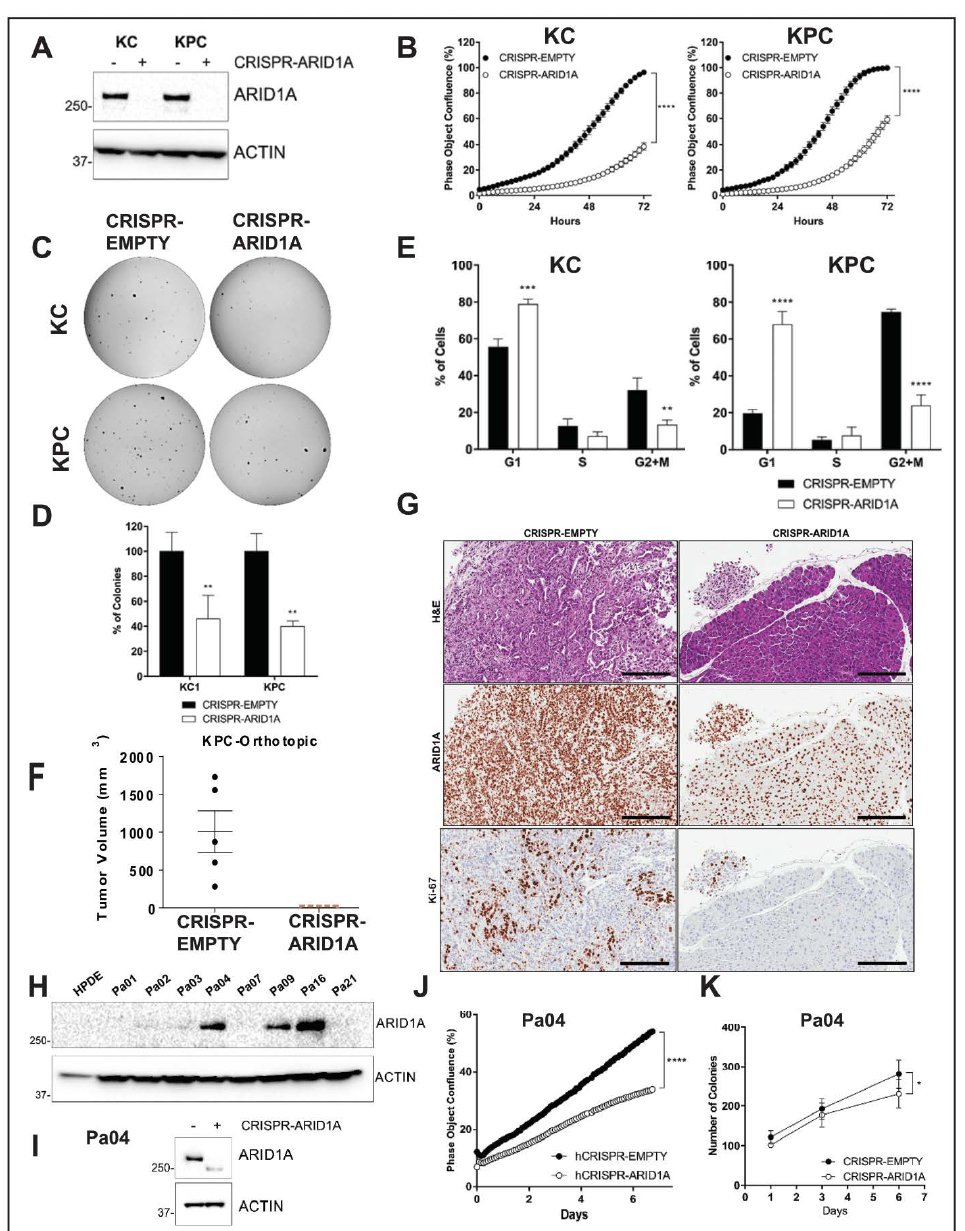
Figure 3. Arid1a loss is deleterious to growth in established PDAC cell lines. ( A ) Immunoblotting for ARID1A showed complete loss of expression in “KC” and “KPC” cell lines transfected with CRISPR / Cas9 targeting mouse Arid1a . ( B ) Monolayer culture in vitro showed reduced proliferation in Arid1a -deleted “KC” and “KPC” isogenic cell lines, represented as measure of culture confluence. Images were captured every 2 h using the live-imaging system (Incucyte ZOOM) and data represented as mean ± SD. ****, p <